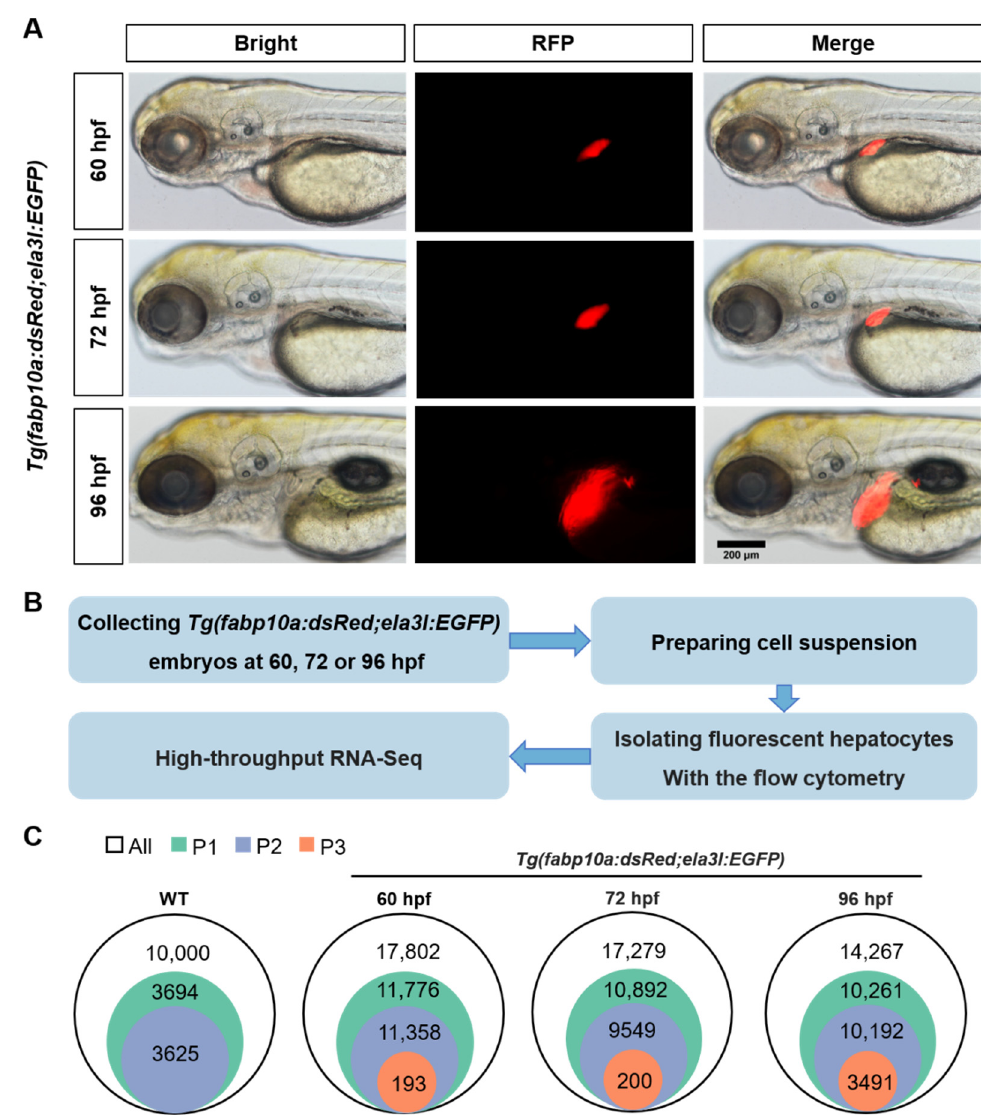
Figure 1. The isolation of zebrafish hepatocytes. ( A ) The size changes of red-fluorescent liver at 60, 72, and 96 hpf in transgenic zebrafish Tg(fabp10a:dsRed;ela3l:EGFP) . Scale bar, 200 µm. ( B ) The technical roadmap for isolation of zebrafish hepatocytes. ( C )The cell populations of hepatocytes sorted from Tg(fabp10a:dsRed;ela3l:EGFP) embryos at 60, 72 and 96 hpf.